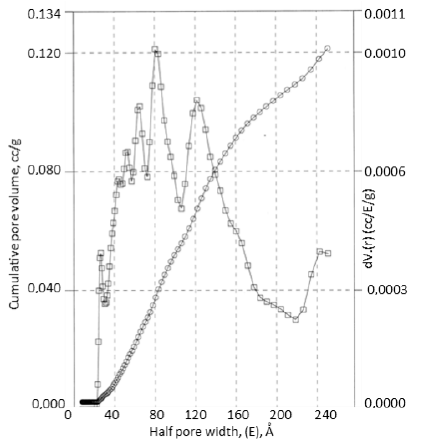
Figure 6. The function of pore volume distribution on the effective radius for the cellulose-hydroxyapatite composite membrane (Ssp. = 32 m 2 /g; Vs = 0.16 cm 3 /g), ○ —V, □ —dV.